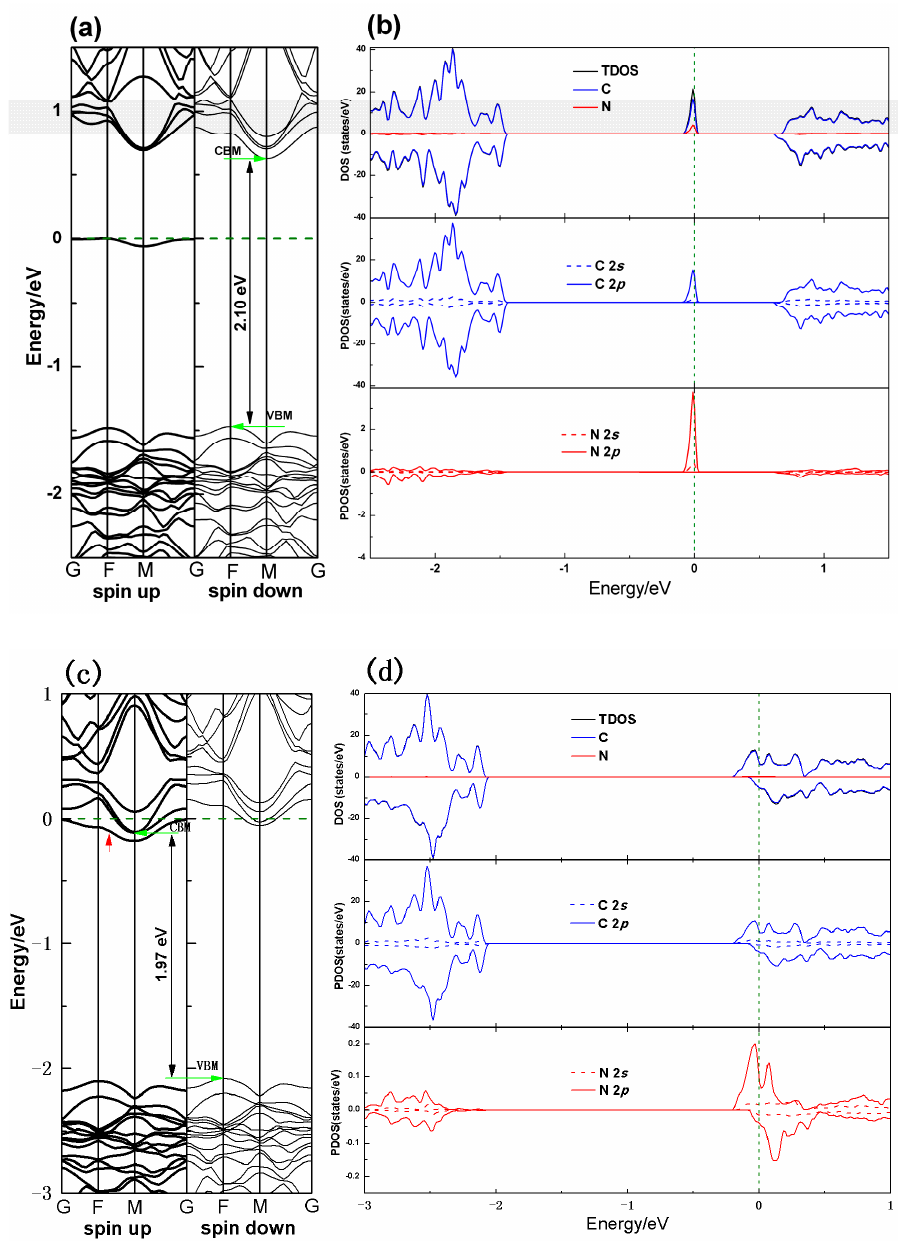
Figure 4. Calculated electronic energy band structure, TDOS and PDOS of the PG–N (sp 2 ) (( a ) and ( b )) and PG–N (sp 3 ) (( c ) and ( d )) systems. The black solid line in the density of states shows the TDOS of the system. The blue and red lines indicate the PDOS of carbon and nitrogen atoms, respectively. The olive dash lines represent the Fermi energy level. The energy level marked by the red arrow in the spin-up states in ( c ) is an impurity energy level due to the introduction of the nitrogen